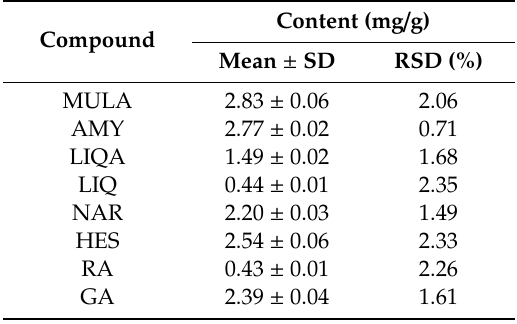
Table 4. Quantification of the eight marker components in HPYJT sample.